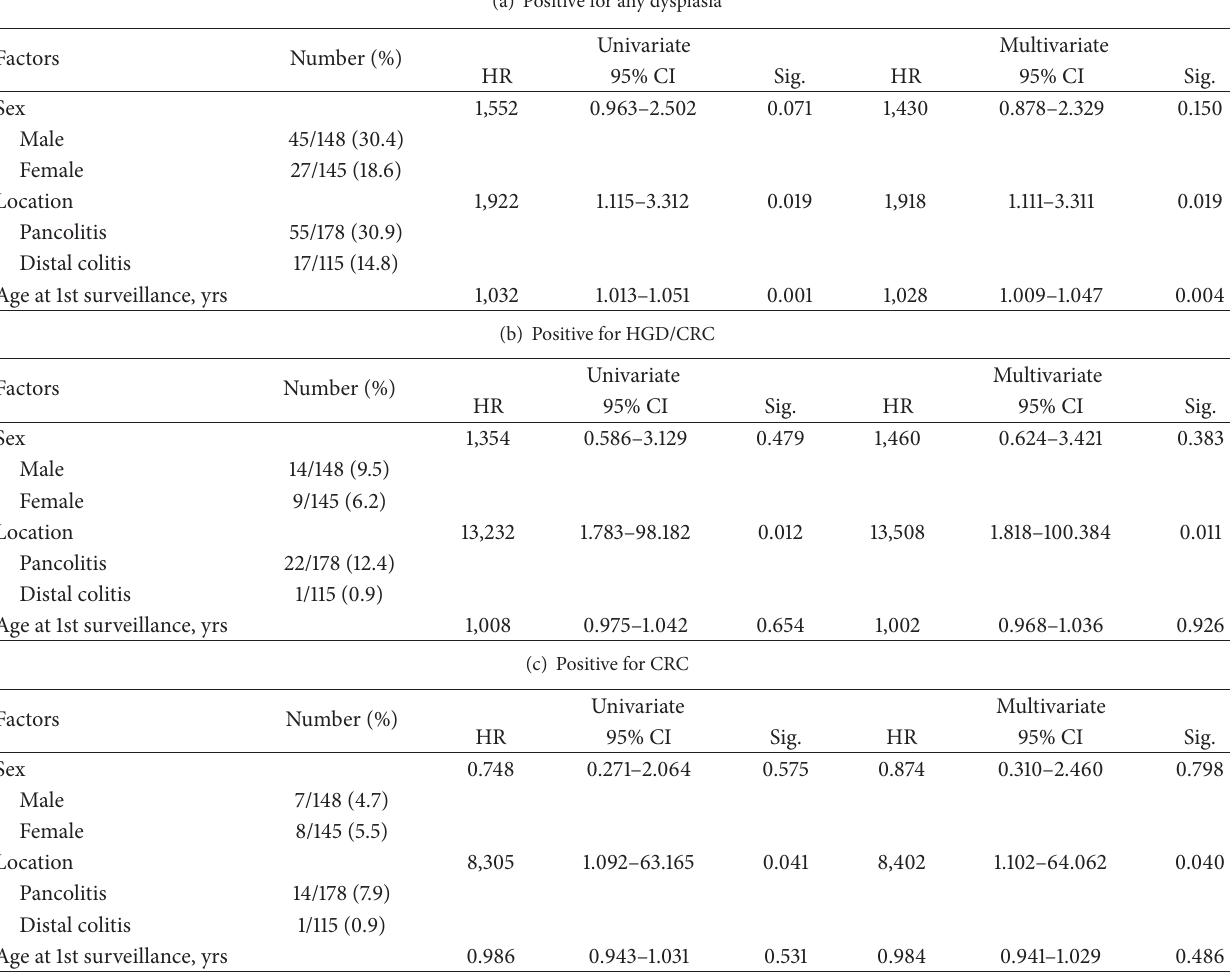
Table 2: Cox regression analysis per independent